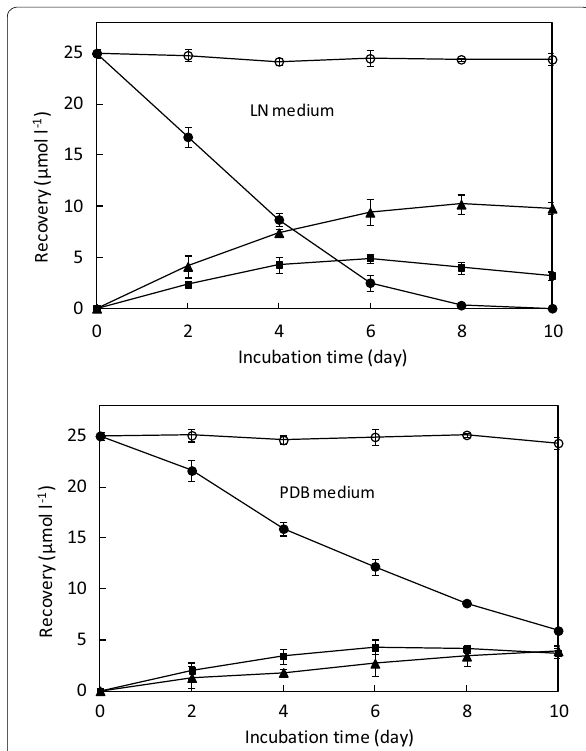
Fig. 1 Time course for degradation of PCP ( closed circles ) and formation of PCA ( closed triangles ) and TCHQ ( closed squares ) by P. acanthocystis in LN and PDB media. Recovery of PCP from control cultures was also shown ( open circles ). Values are mean triplicate samples